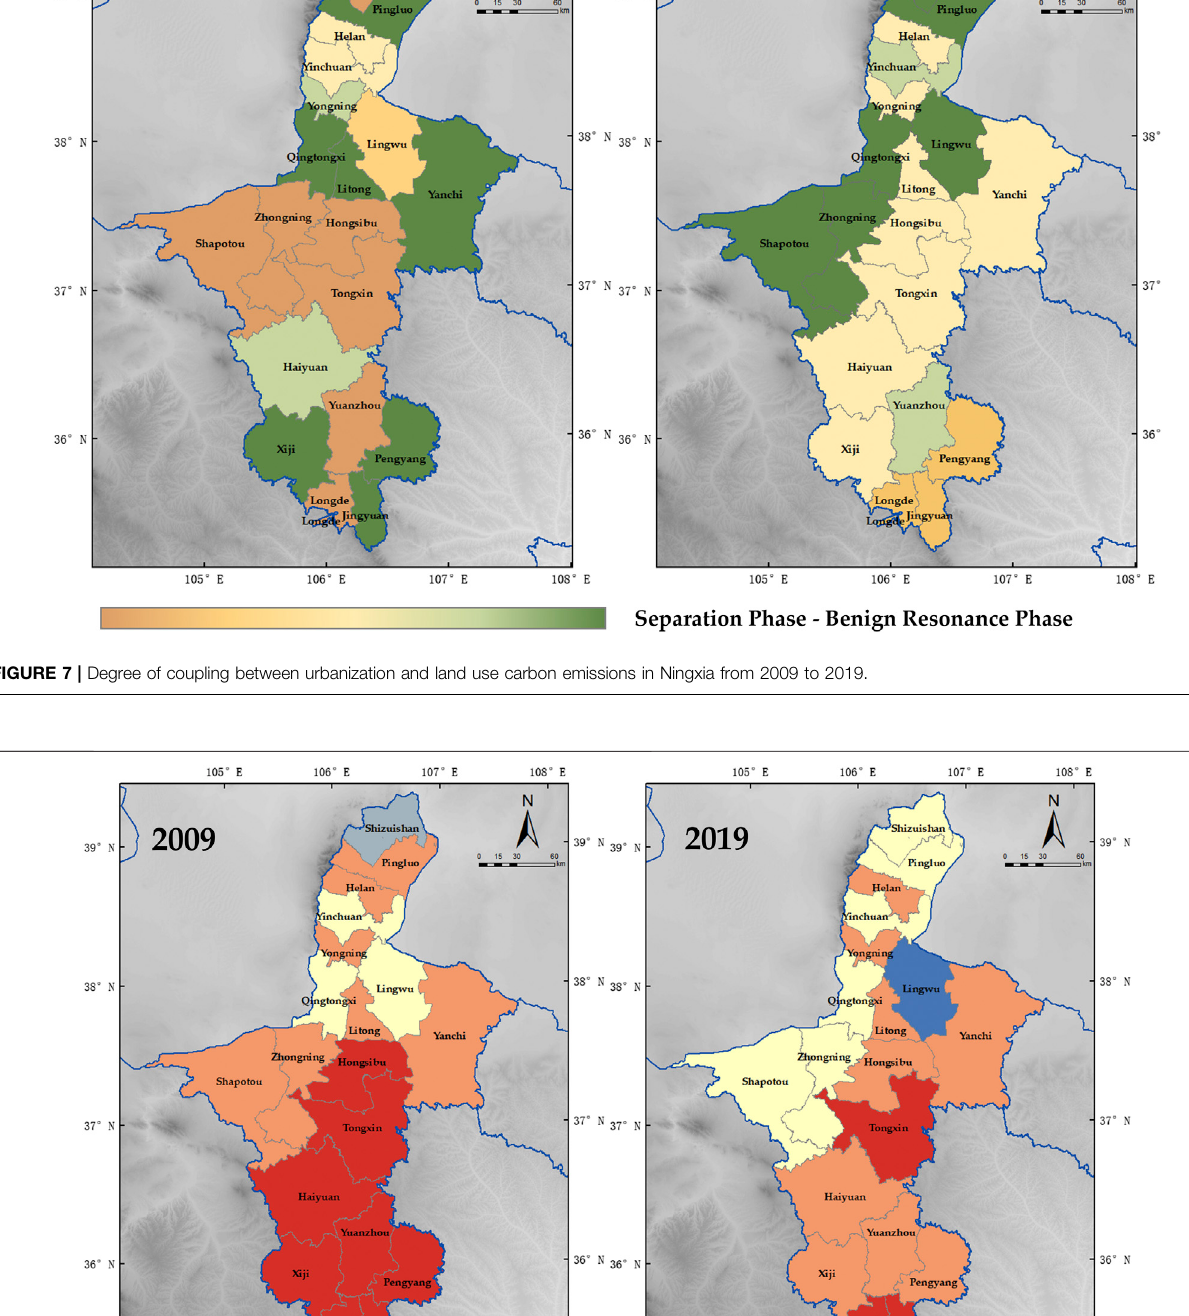
Frontiers in Environmental Science |